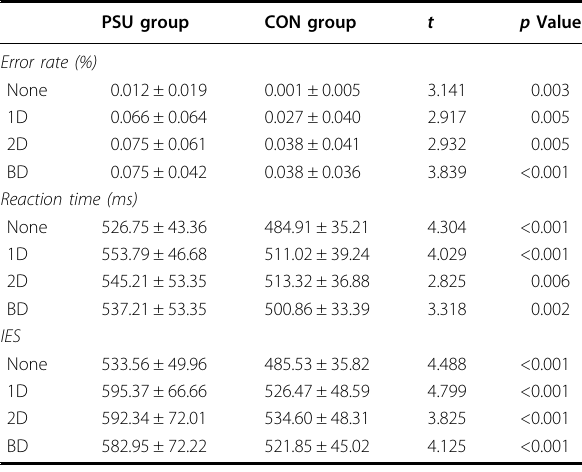
Table 1 Behavioral performance. Table 2 Brain regions showing activation differences between groups in each condition.